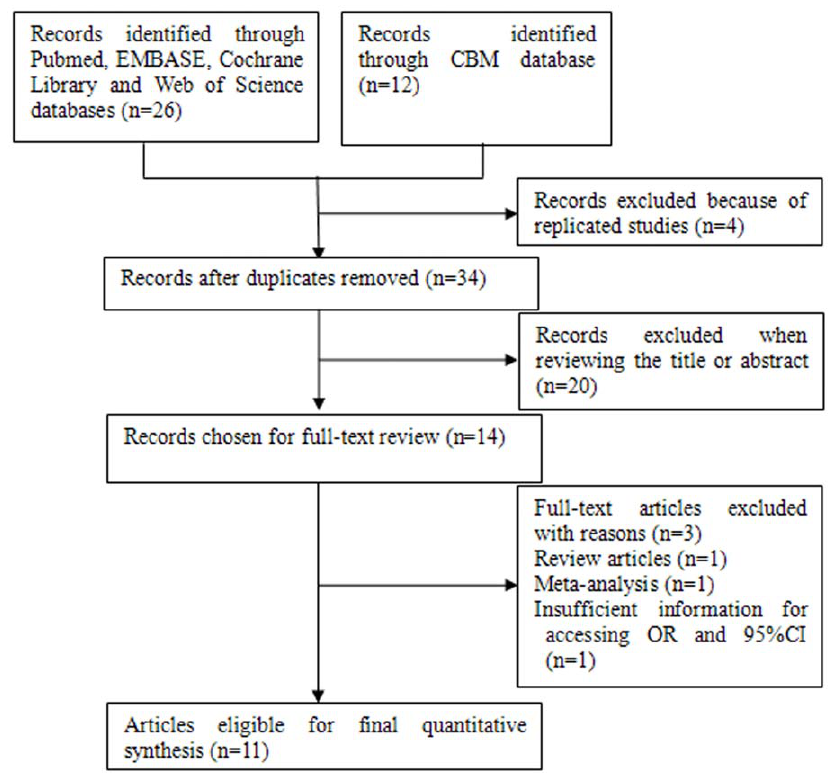
Figure 1. Flow diagram of included studies for this meta-analysis.